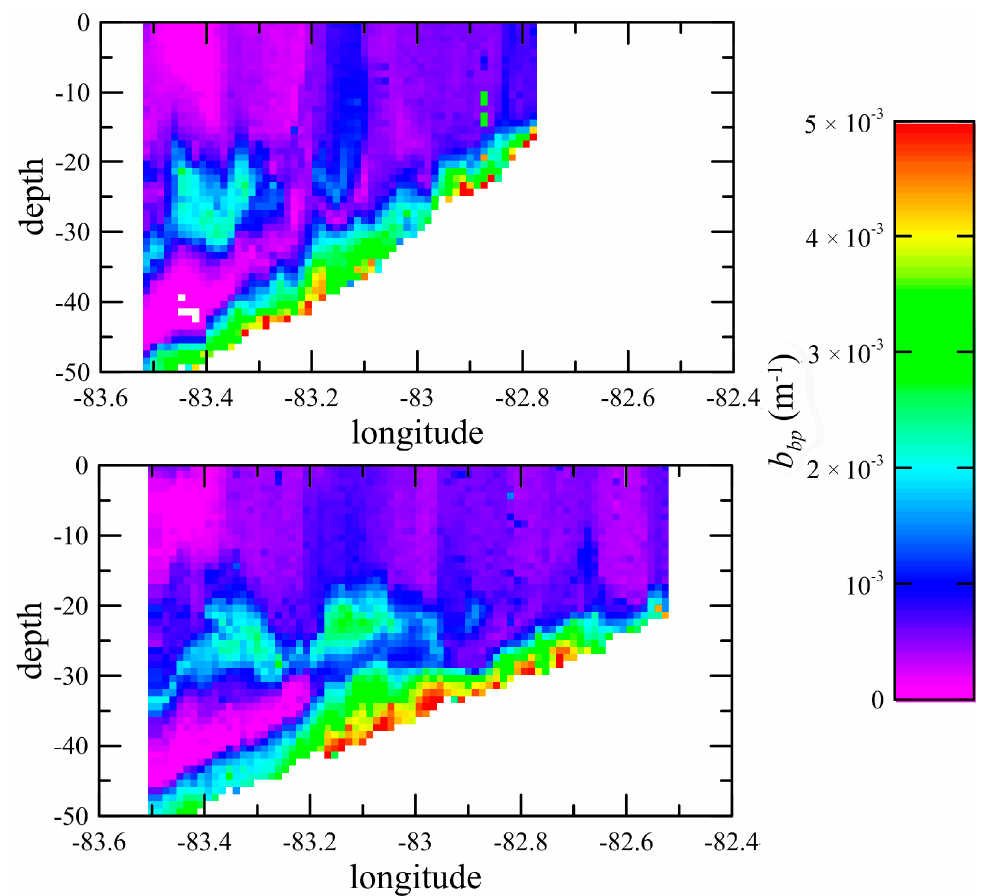
Figure 2. Glider-measured particulate backscattering coefficient b bp as a function of depth and longitude according to the color table at the right. Plot shows the glider data binned into 0.01° latitude by 1 m depth bins for the east to west ( top ) and return transect ( bottom ).